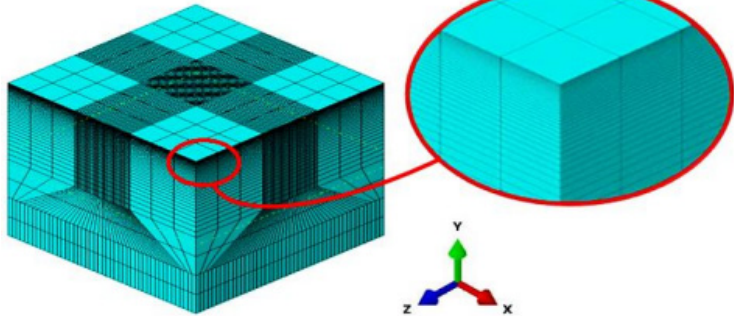
Figure 2. The discretized finite elements mesh of the geometric model.